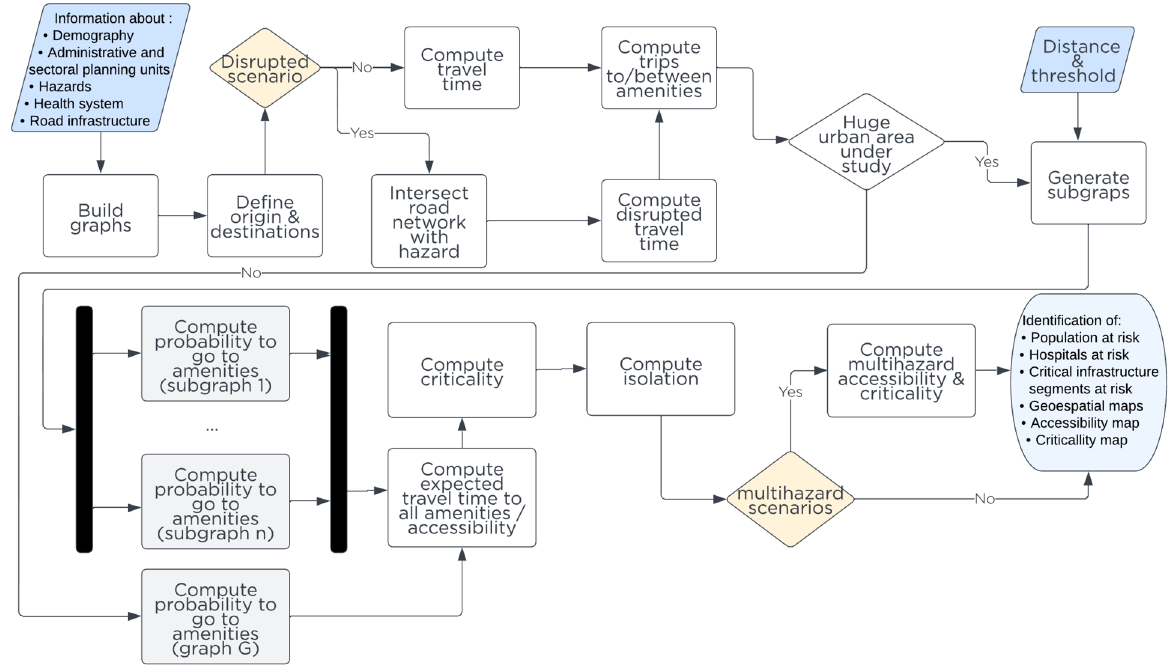
Figure 1. Methodology schema of population accessibility and infrastructure criticality estimation.